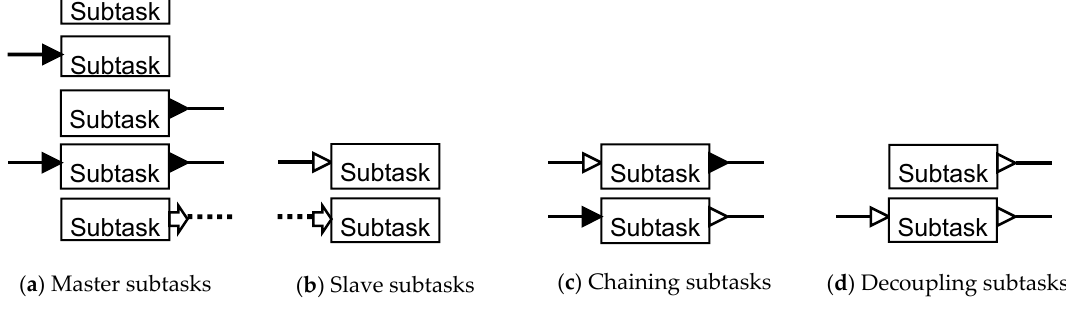
Figure 6. Graphical depictions of subtask types.